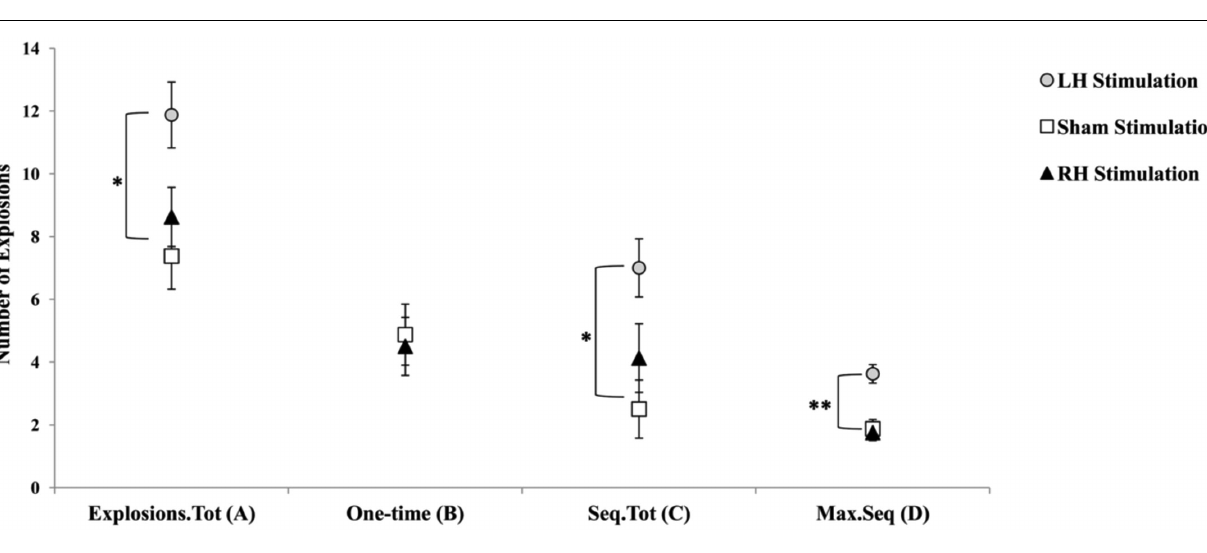
explosions; (C) Seq.Tot = total number of sequential balloon explosion; (D) Max.Seq = maximum number of balloon explosions in a sequence. Error bars indicate SEM. * p < 0.05. ** p < 0.01.